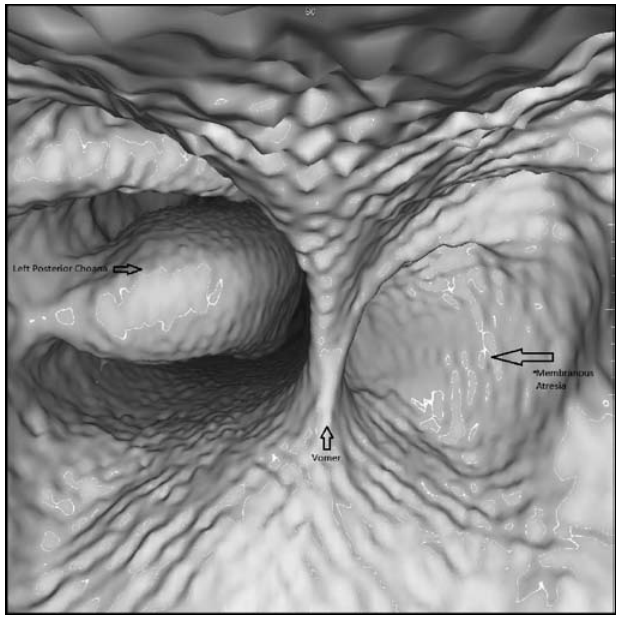
Fig. 2. Posterior nasopharynx CT virtual endoscopic view. Roof of nasopharynx above and soft palate below. Right-sided membranous atresia